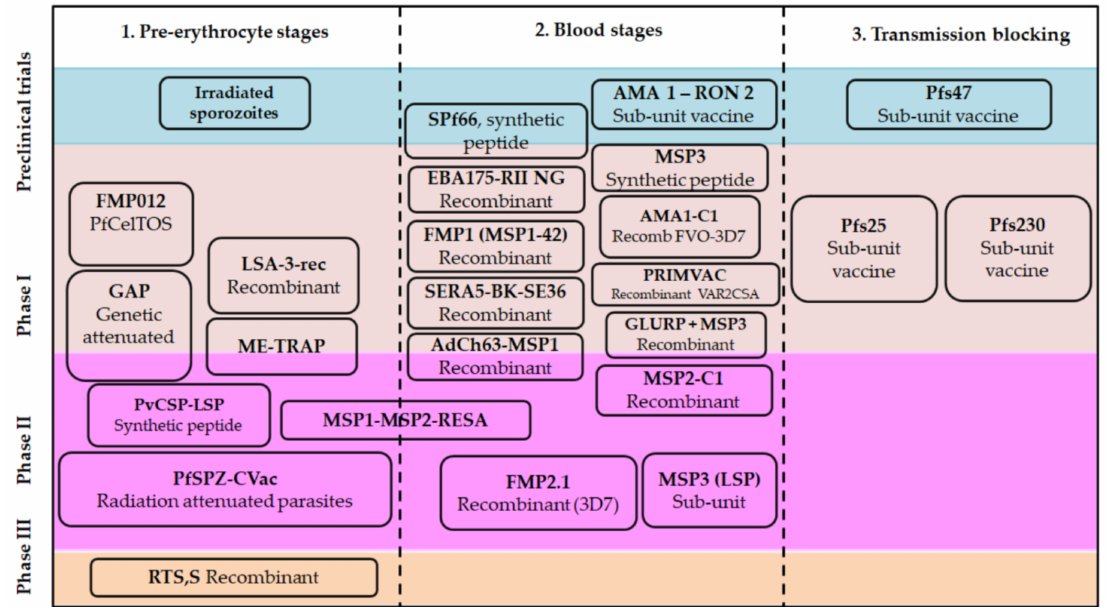
Figure 2. Progress in developing vaccine candidates for